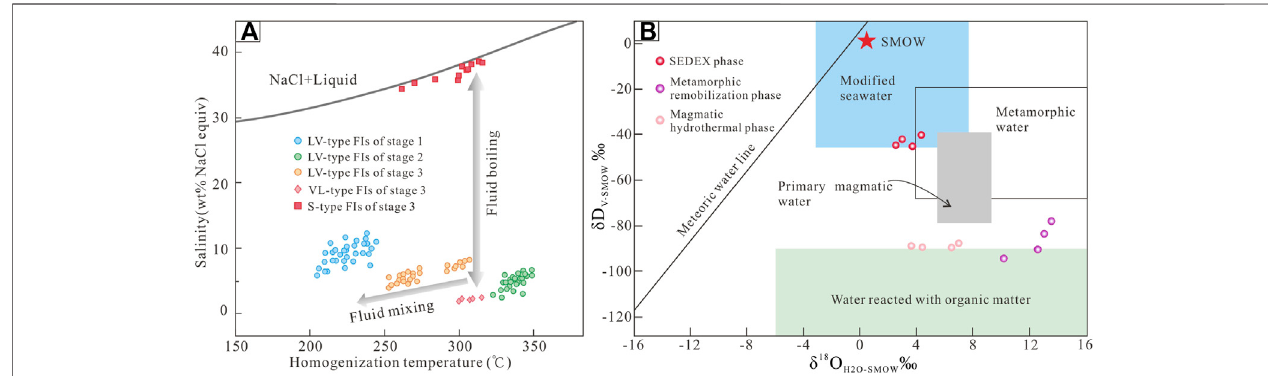
FIGURE 6 | (A) Homogenization temperature vs salinity in the NaCl-H 2 O system for FIAs from three stages in the Haerdaban Pb-Zn deposit. Isobars were calculated using the equations of Driesner and Heinrich (2007) (B) Diagram showing δ D H2O vs δ 18 O H2O , representing different stages of mineralization in the Haerdaban Pb-Zndeposit.Modi fi edseawaterisfromOhmotoandRye(1979),andTornos(2006).Fieldsshowingprimarymagmatic,metamorphic,meteoricwaters,andwaterwith organic matter are from Taylor (1974) and Sheppard (1986).